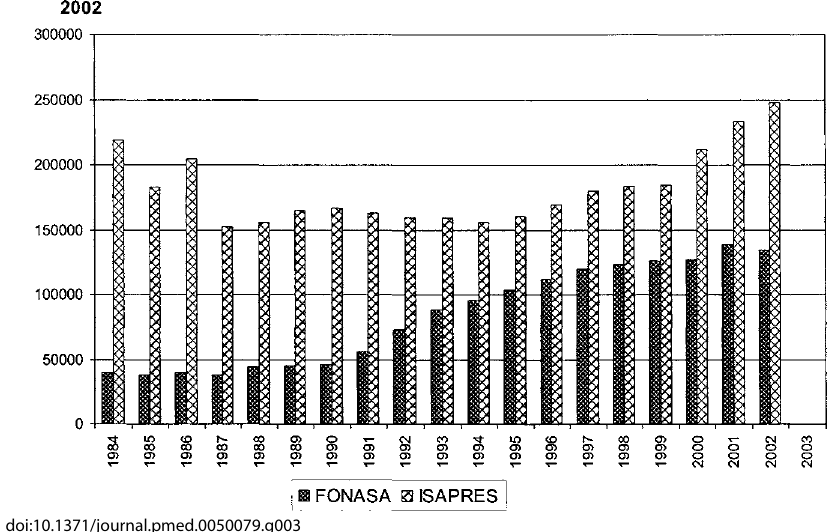
Figure 3. Expenditure per Member, FONASA and ISAPRES, 1984–2002 The graph shows that per capita expenditure was always much higher in ISAPRES than in FONASA, and the difference has expanded in the past years. From [13].